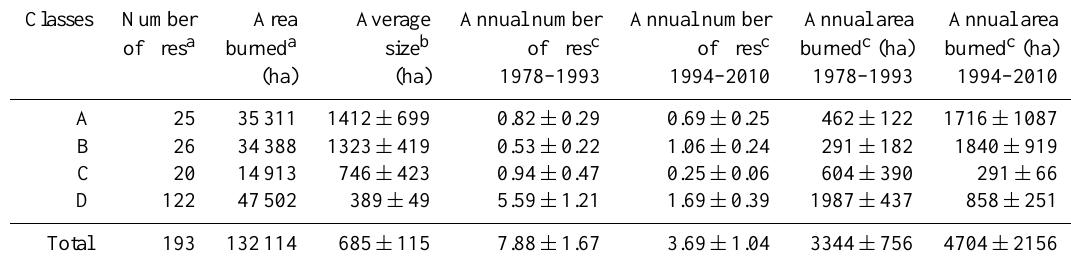
Table 2. Number of large wildland fires (LWFs), area burned and average size in high temperature (HT) classes in Arag´on from 1978 to 2010.